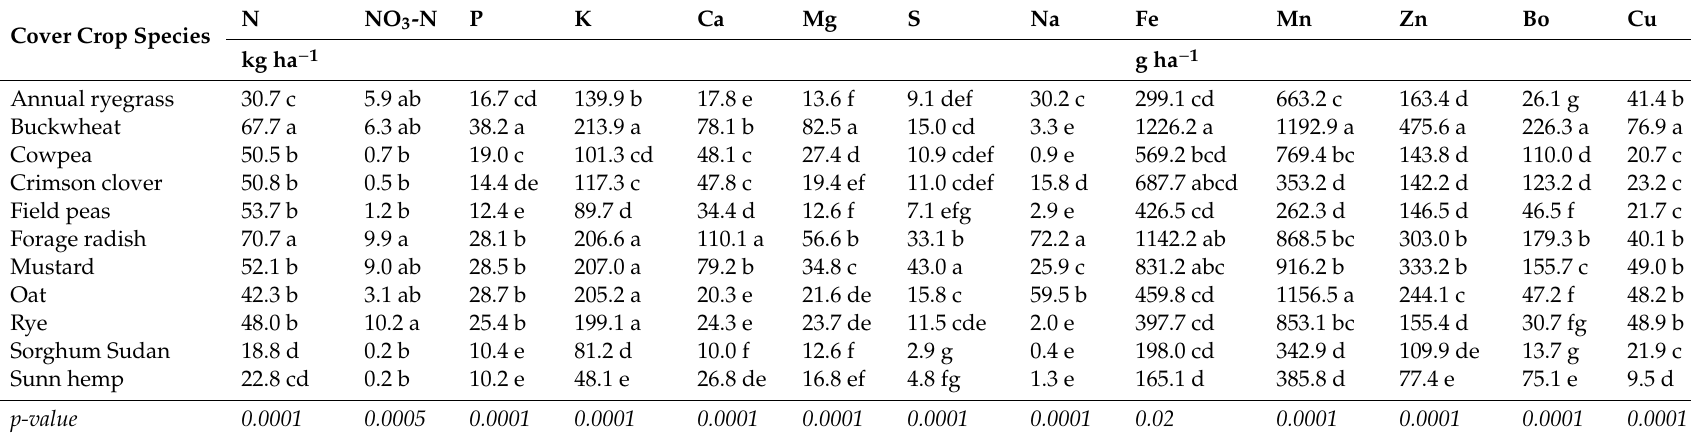
Table 5. Macro and micronutrient uptake and potential contribution to soil fertility of above-ground tissues of selected cover crop species at 46 days after sowing 1 . Cover Crop